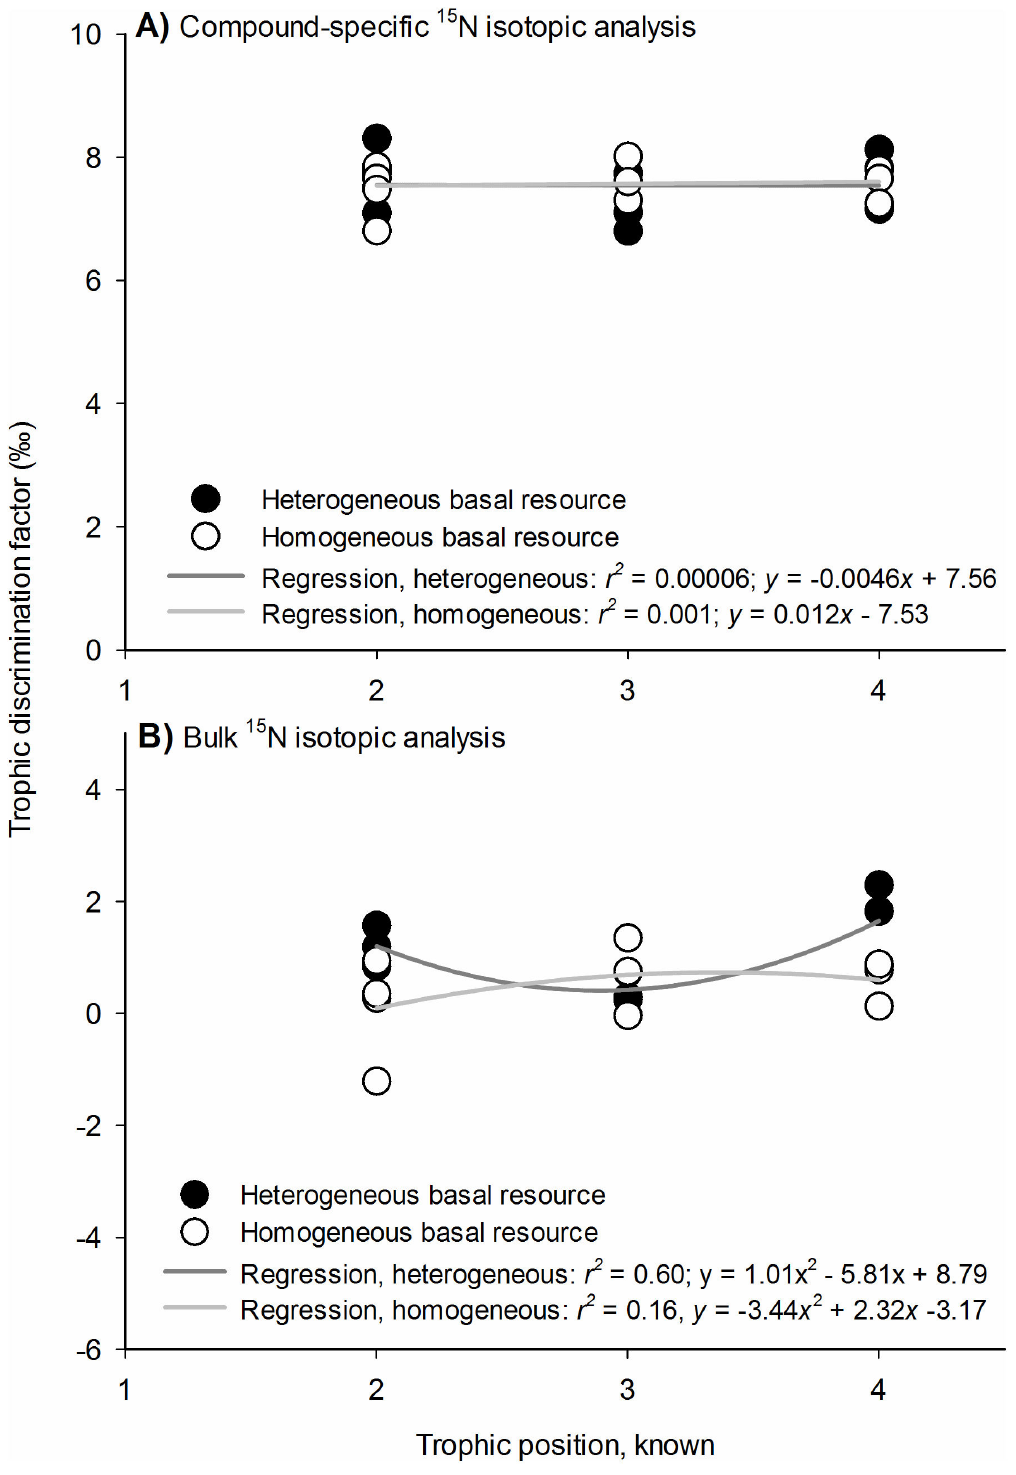
Figure 1. Trophic discrimination factors. Linear regression analysis of trophic discrimination factors (Δ 15 N) deriving from A) CSIA analysis, and B) bulk 15 N analysis. Each point represents the trophic discrimination factor of an individual organism. Discrimination factors depicted at trophic levels 2, 3, and 4 represent the isotopic shifts from levels 1 to 2, 2 to 3, and 3 to 4, respectively. doi: 10.1371/journal.pone.0076152.g001 PLOS ONE |